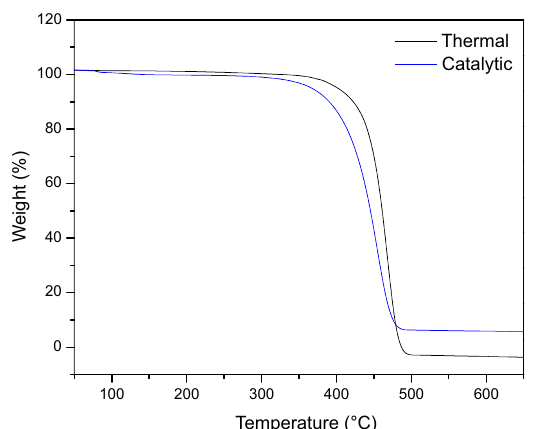
Figure 1. TG plot of plastic sample in thermal and catalytic experiment